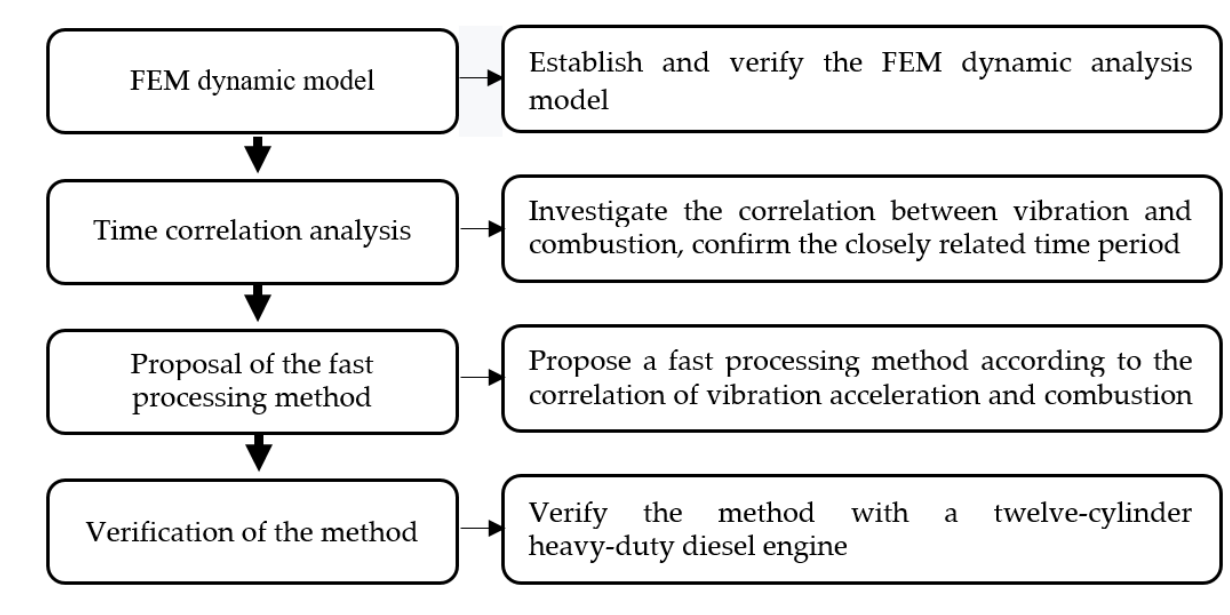
Figure 1. The main research flow chart.